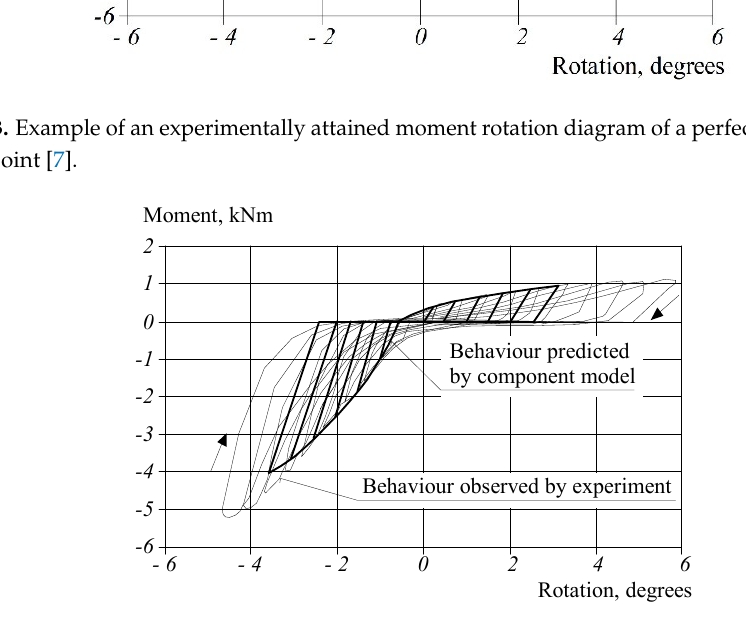
Figure 14. Comparison of the predicted component-based model for cyclic loading in the moment rotation diagram in Figure 13 [7].